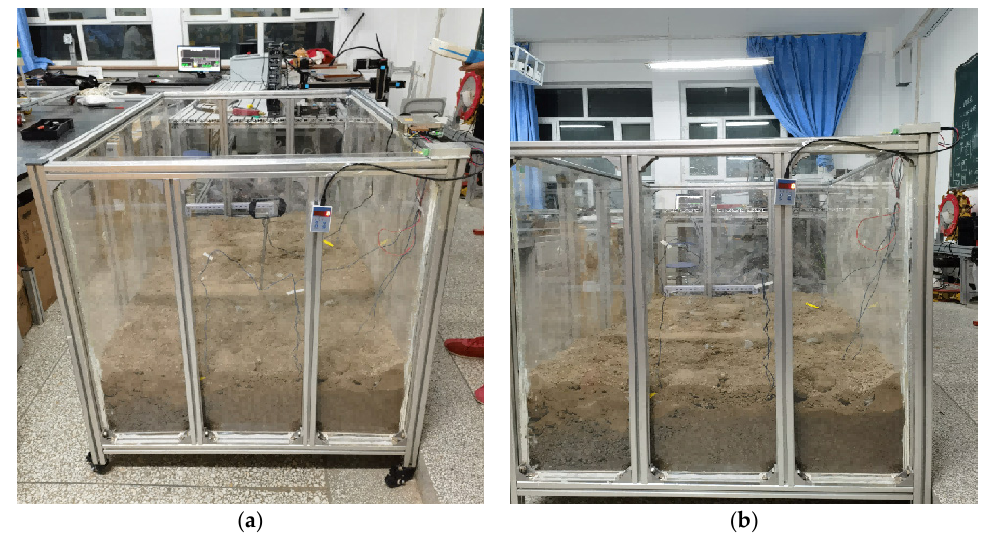
Figure 5. Film lifting test system for small soil trough system. ( a ) Shape of small soil trough; ( b ) Mechanical test system for small soil trough.